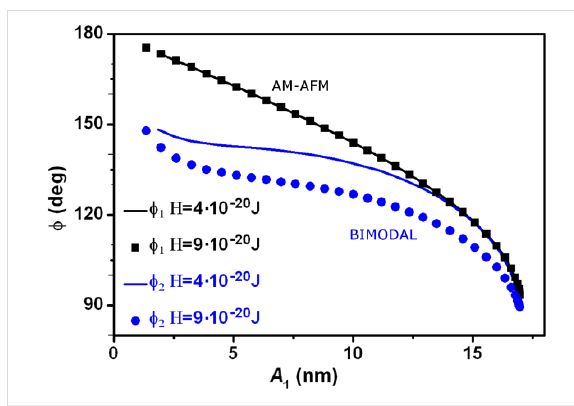
Figure 7: Material contrast in bimodal AFM. Phase shift as a function of the set-point amplitude in bimodal AFM ( versus A 1 ). To illustrate the bimodal effect, we show the simulations for regular AM-AFM ( versus A 1